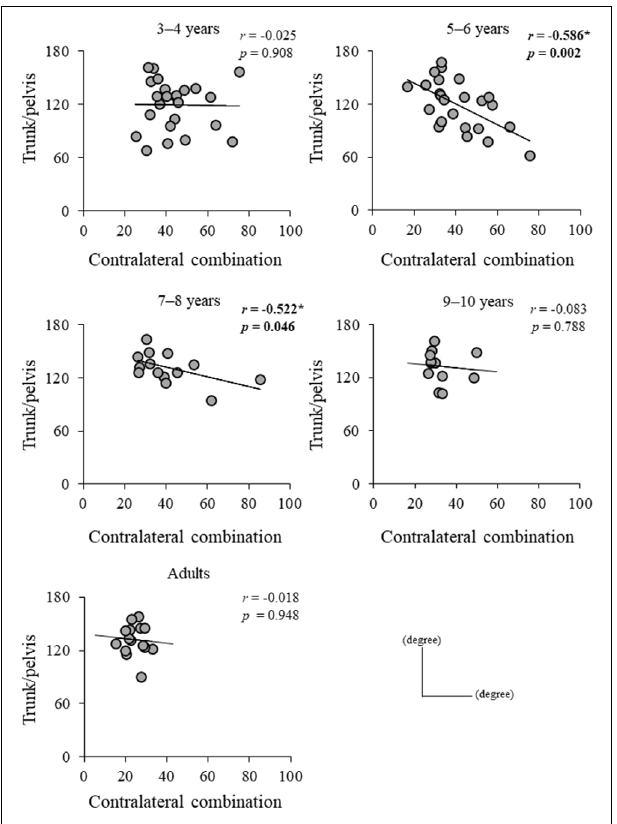
FIGURE 8 | Relationship between mean relative phase (MRP) of contralateral arm and leg combination and MRP of trunk/pelvis combination for each group. *,Significant correlation, p <